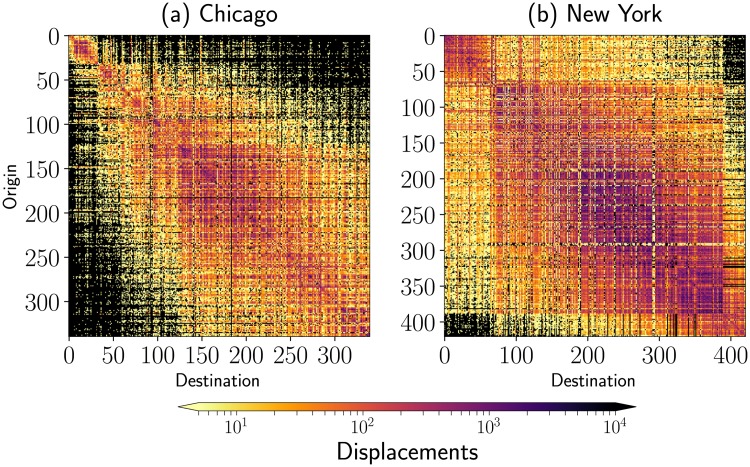
Origin-destination matrices for bike-sharing systems.We present the results obtained for the city of (a) Chicago (N = 340) and (b) New York (N = 421). The geographical coordinates (longitude, latitude) of stations are sorted starting from the southern locations and considering the order of longitudes from west to east. The number of displacements or trips between origin and destination stations is codified in logarithmic scale in the colorbar; null entries are represented in white.